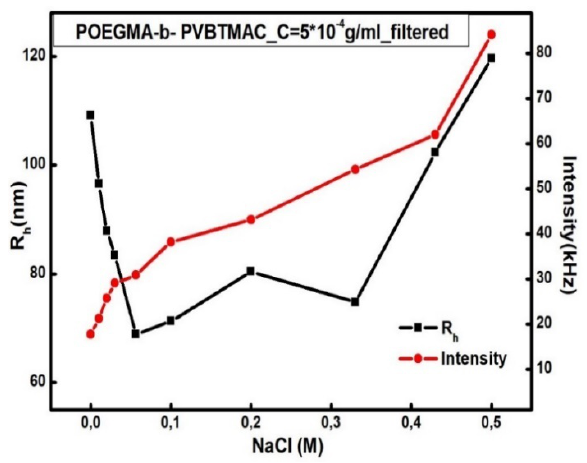
Figure 4. R h and scattered intensity as a function of ionic strength ([NaCl]) for POEGMA- b -PVBTMAC at C = 5 × 10 −4 g/mL.